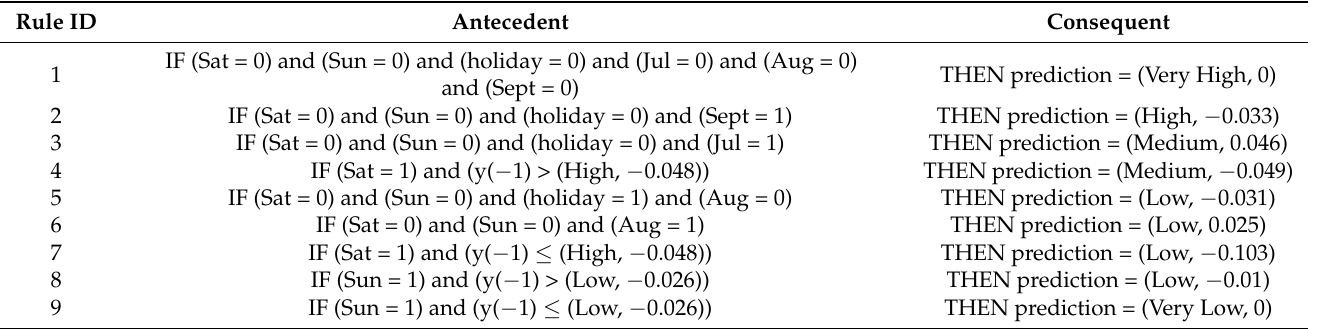
Table 6. Surrogate rules obtained for the LSTM model with 2-tuple linguistic